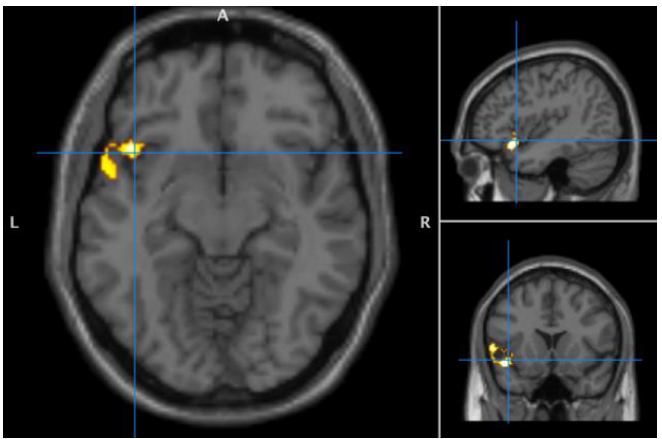
Figure 2. Higher level of functional connectivity strength of right posterior intraparietal sulcus (IPS) seed with left insula and temporal lobe for FM compared to HC. Seed-voxel analysis with right IPS as seed in an exploratory between-group comparison without including anxiety and depression scores, or pain sensitivity.